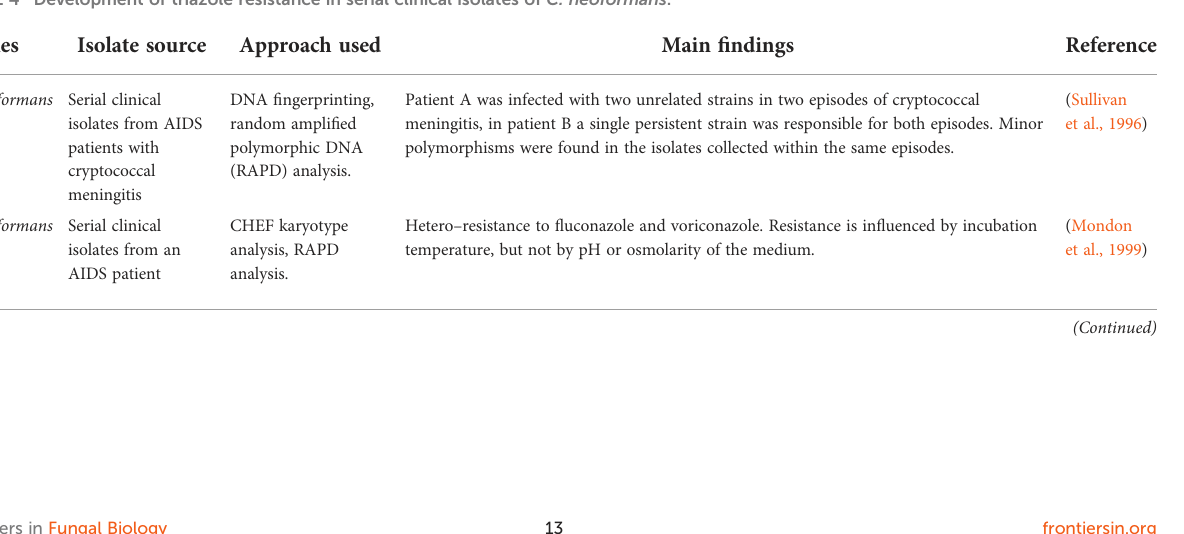
TABLE 4 Development of triazole resistance in serial clinical isolates of C. neoformans